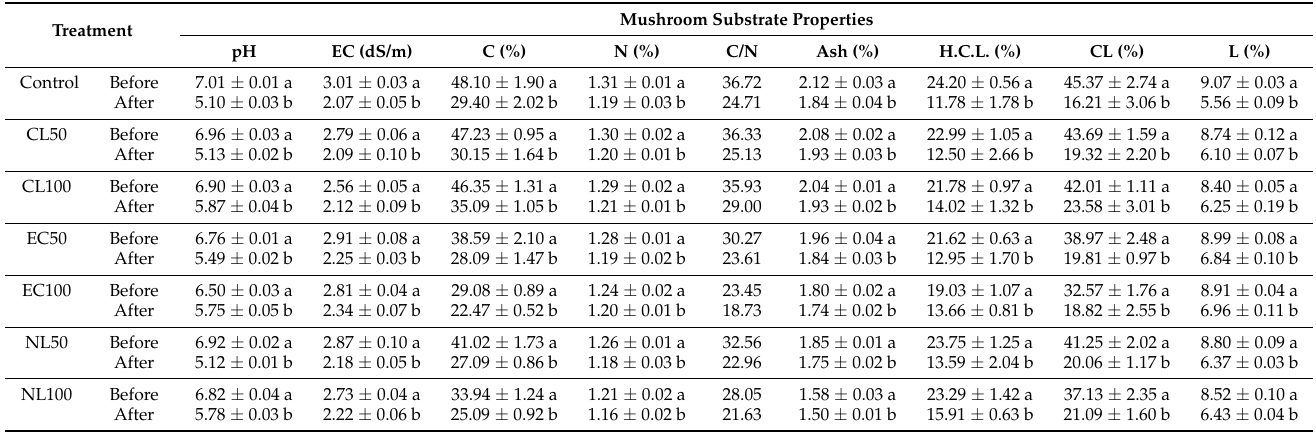
Table 1. Changes in properties (mean ± SD of five replicates) of wetland plant biomass-based substrates before and after P. florida cultivation.